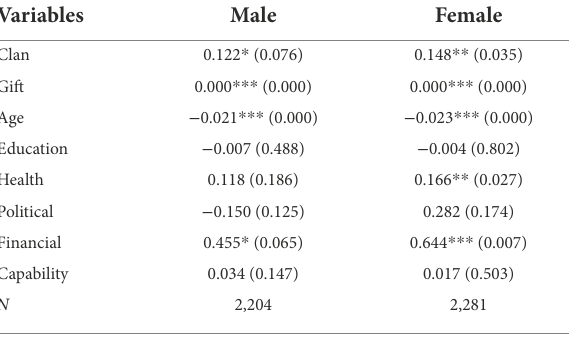
TABLE 6 Estimated results of the income determination equation for farmers’ entrepreneurship (by